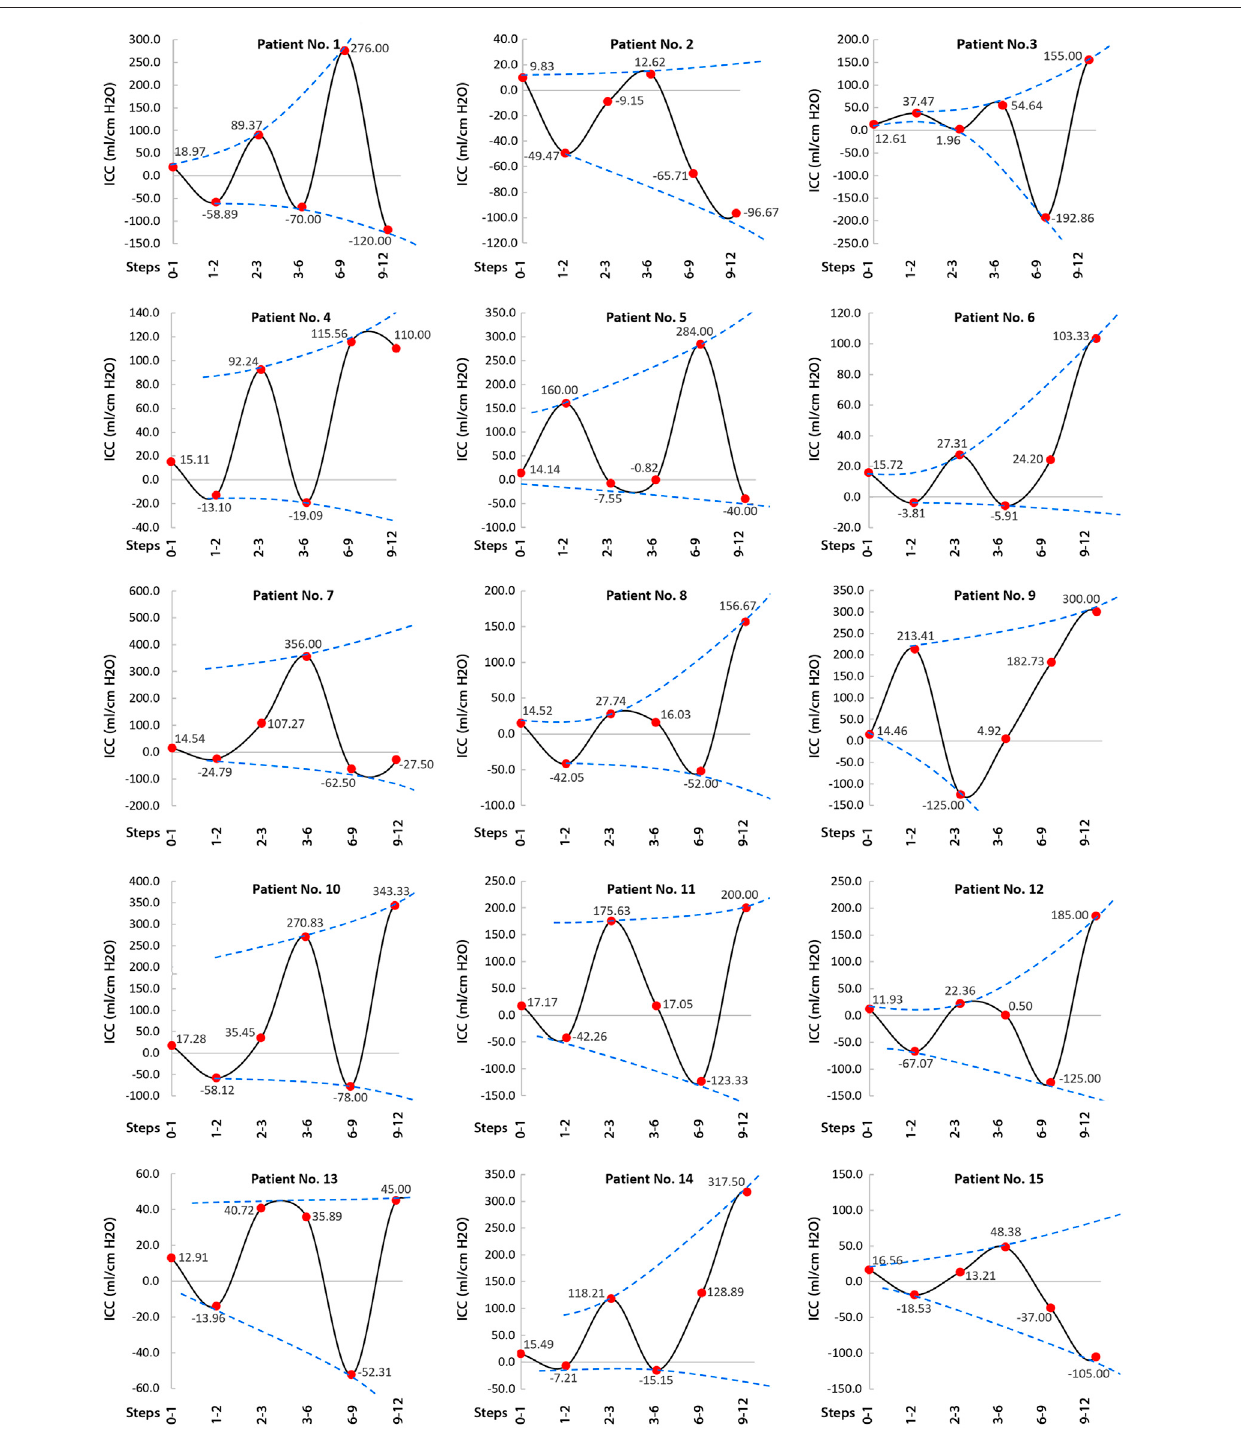
FIGURE 6| Long-term ICC changesfrom prior to shunting to 12 months after shunting. The long-term ICC changes between prior to shunting and the fi rst month after shunting are shown by the fi rst red circle on the left side of each panel. The de fi nitions of steps 0-1, steps 1-2, steps 2-3, steps 3-6, steps 6-9, and steps 9-12 in horizontal axes are the long-term ICC values between prior to shunting and 1 month after shunting, between 1 and 2 months after shunting, between 2 and 3 months after shunting, between 3 and 6 months after shunting, between 6 and 9 months after shunting, and between 9 and 12 months after shunting, respectively. It shouldbenotedthatafter6months,theICPchanges(numeratorofICCequation)andCSFVchanges(denominatorofICCequation)were1.98and4.70%,respectively. Hence, despite an oscillatory increase in long-term ICC values over the course of 12 months, this increase until 6 months after shunting (0-1, 1-2, 2-3, and 3-6 steps) is